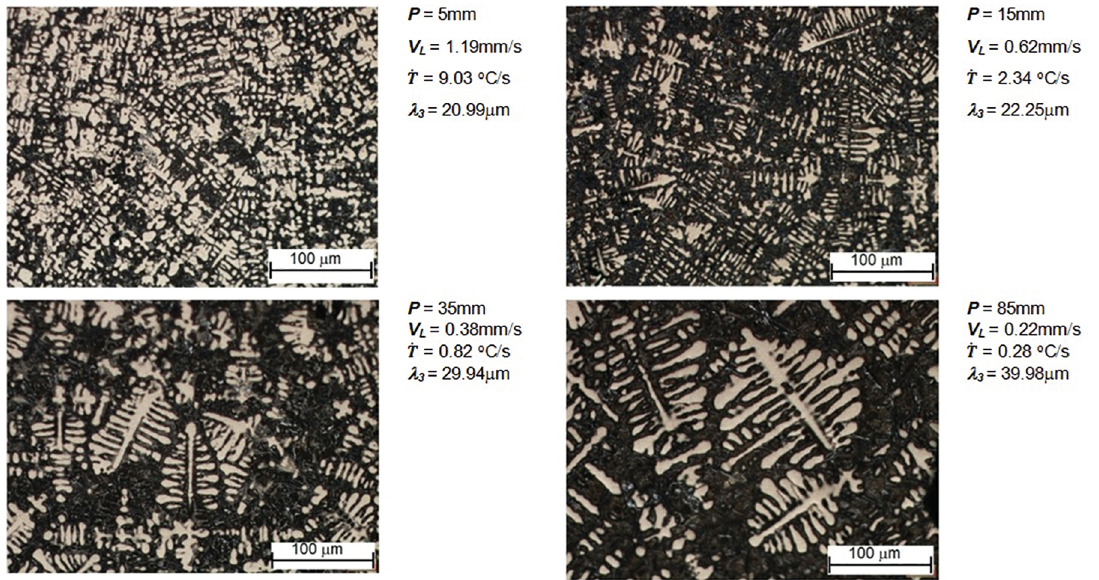
Figure 6. Photomicrographs of samples from transverse sections along the casting length.